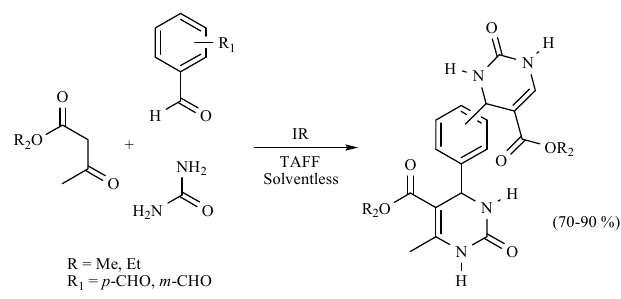
Scheme 15. Production of bis -DHPMs.